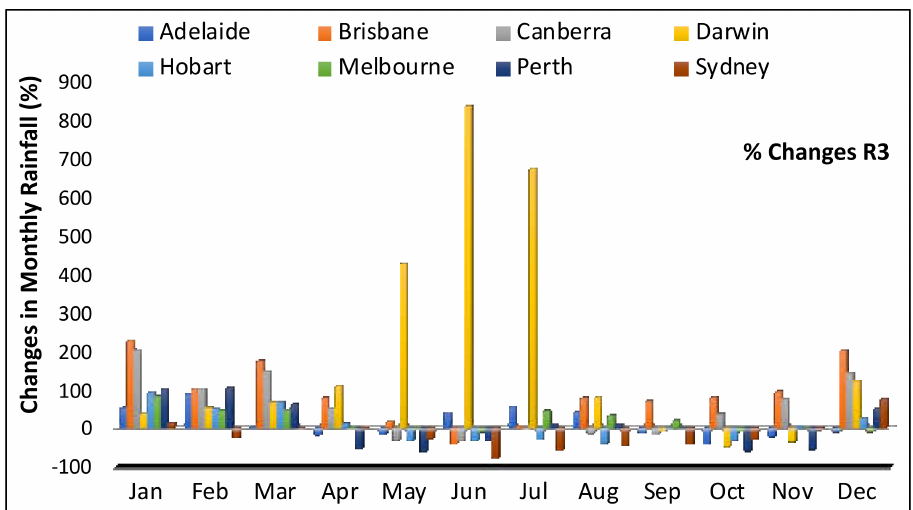
Figure 13. Changes in monthly average rainfall at the eight Australian capital cities from 2022–2039 in comparison to the historical rainfall average.